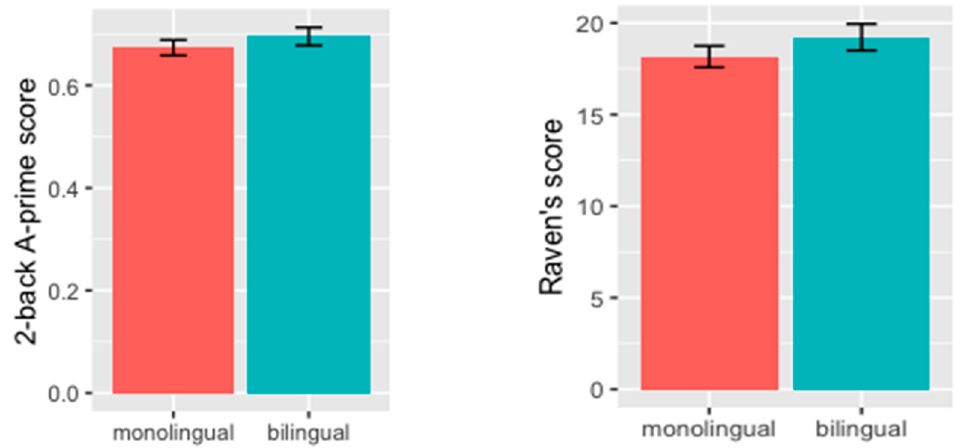
Figure 4. Overview of the positive correlations between bilingualism and cognitive scores; 2-back score in the left graph and Raven’s score in the right graph.